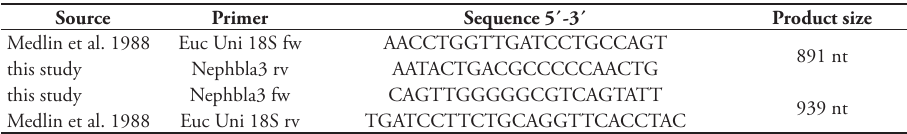
Table 1. Primer sets used to amplify the SSU rDNA of Nephridiophaga blattellae , N. blaberi, and N.